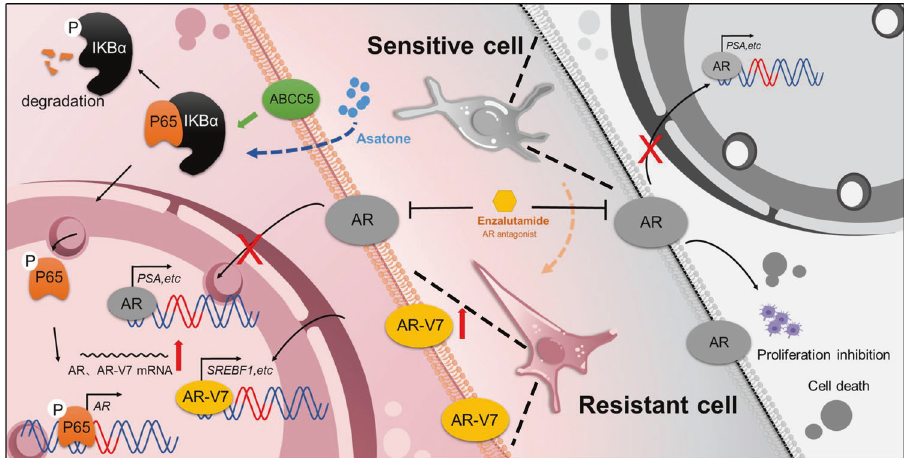
Fig. 7 Schematic diagrams illustrating the role of ABCC5. The long-term burden of enzalutamide treatment induces ABCC5 high expression. Elevated ABCC5 promoted P65 phosphorylation and promotes AR-antagonist resistance via AR splicing variant 7